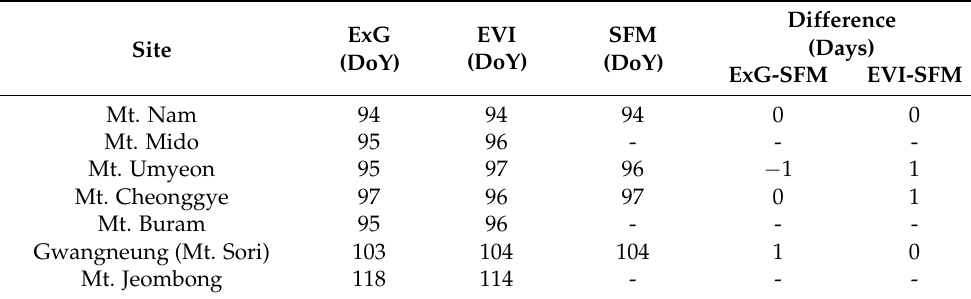
Table 6. Comparisons of green-up dates derived from vegetation phenology (ExG and EVI) and sap flow